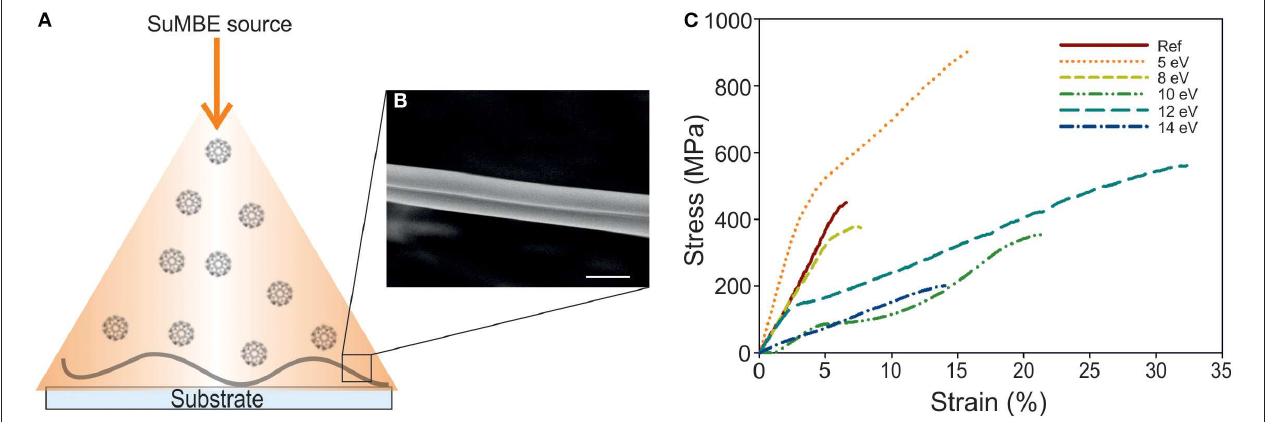
FIGURE 1 | (A) Schematic of the SuMBE process for C 60 molecules deposition onto a spider silk fiber [detailed in the SEM image (B) . Scale bar: 2 µ m]. During implantation, 5ML of fullerenes were deposited. (C) Comparison between example stress-strain curves derived from tensile tests on raw fibers and SuMBE processed fibers at different KE (5, 8, 10, 12, and 14 eV). The example stress-strain curves here reported were selected as representative of their mean behavior and all are reported in the Supplementary Material